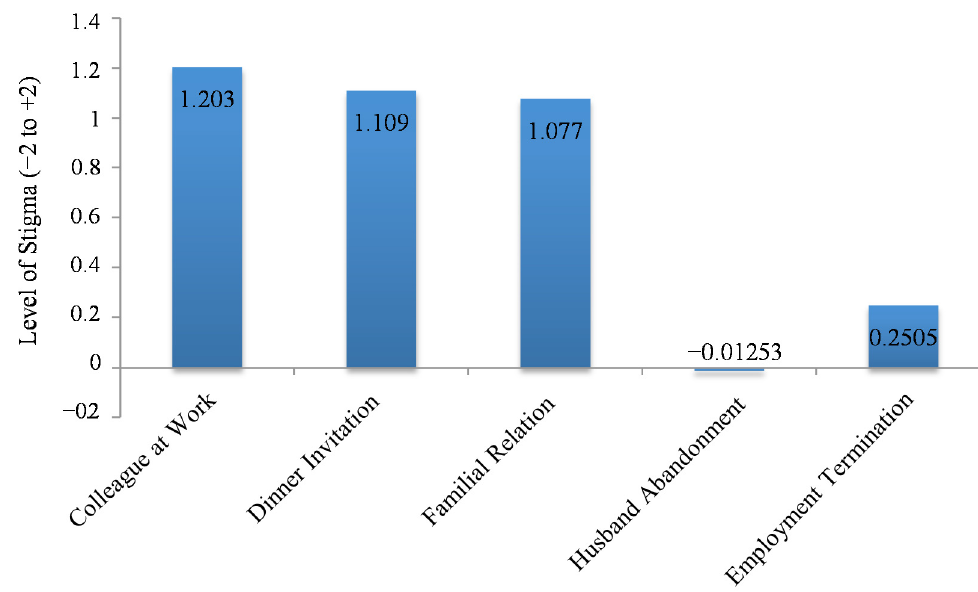
Figure 1. Levels of stigma elicited based on the vignette on a − 2 to +2 scale for each individual